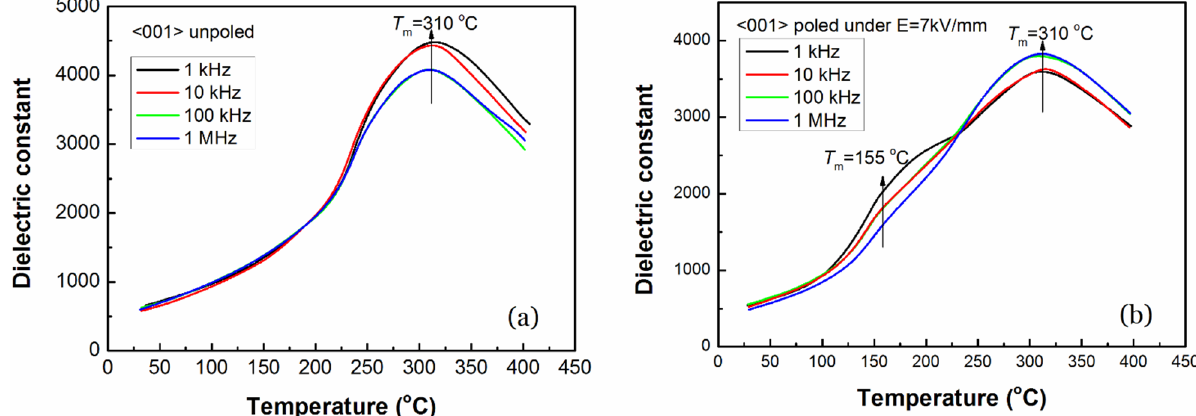
Figure 5. Dielectric constants as a function of temperature and frequency for ( a ) unpoled and ( b ) poled <001>oriented NBT-BT 98/2 crystal. Reprinted with permission from [24]. Copyright 2008